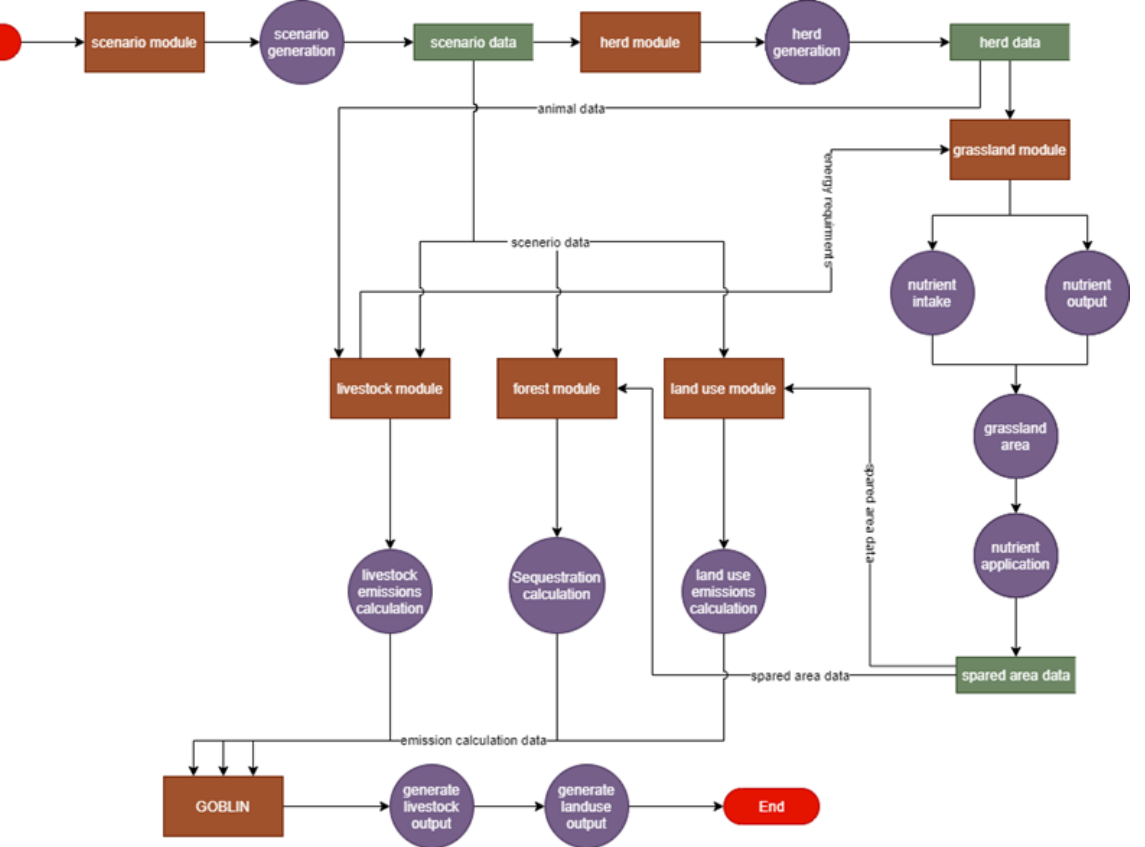
Figure 2. GOBLIN data flow diagram. Arrows represent data flow. Modules are represented by brown rectangles, processes are represented by purple circles, and open-ended green rectangles represent data